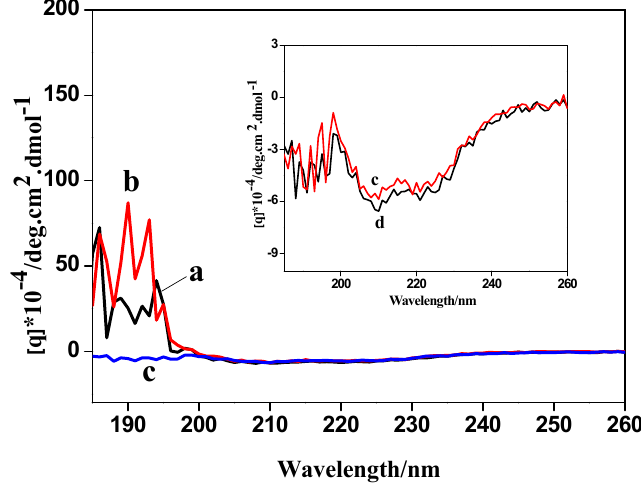
Figure 2. Circular dichroism (CD) spectra of (a) actin, (b) anti ‐ actin, (c) actin/anti ‐ actin and (d) actin/anti ‐ actin/chitosan ‐ Zn.